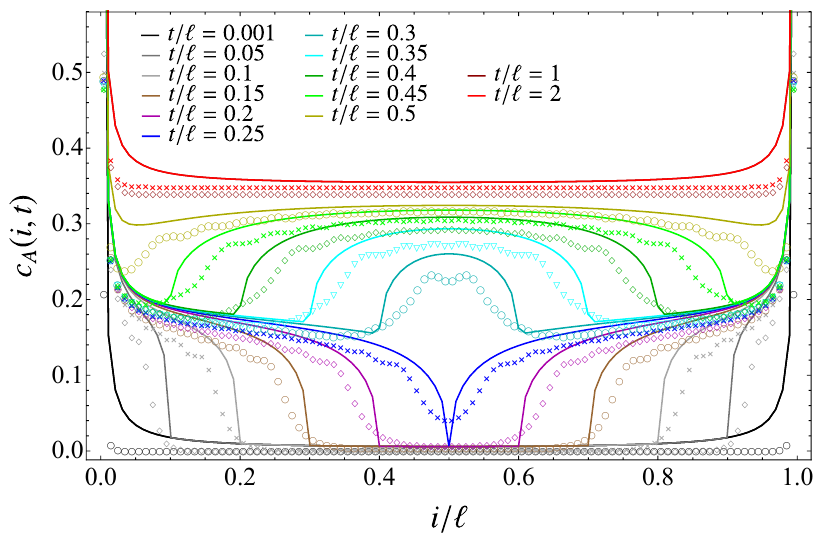
Figure 10 . Temporal evolution of the contour of the capacity of entanglement of an interval made by ‘ = 100 sites after the mass quench in the infinite harmonic chain. In the quench considered ω 0 = 1 and ω = 0 . The quasi-particle formula provides the solid lines in all the